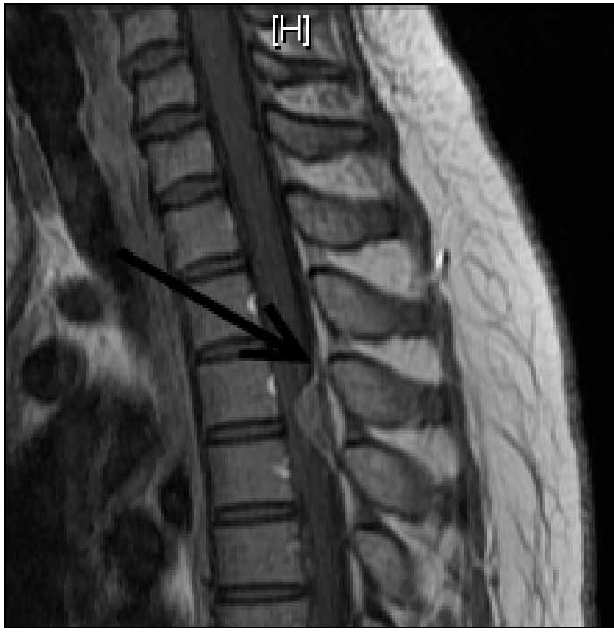
Fig. 3. Saggital T1-weighted spin-echo MR image of the upper thoracic spine demonstrates a dural tail (arrow) associated with a spinal